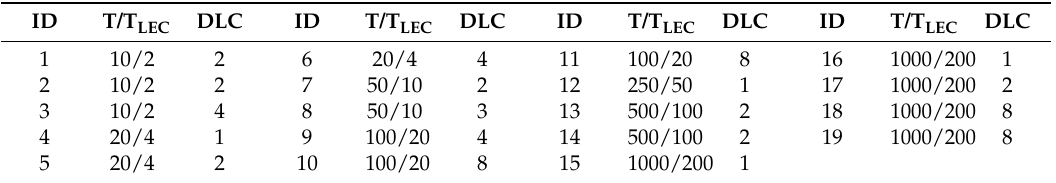
Table A3. VEIL message